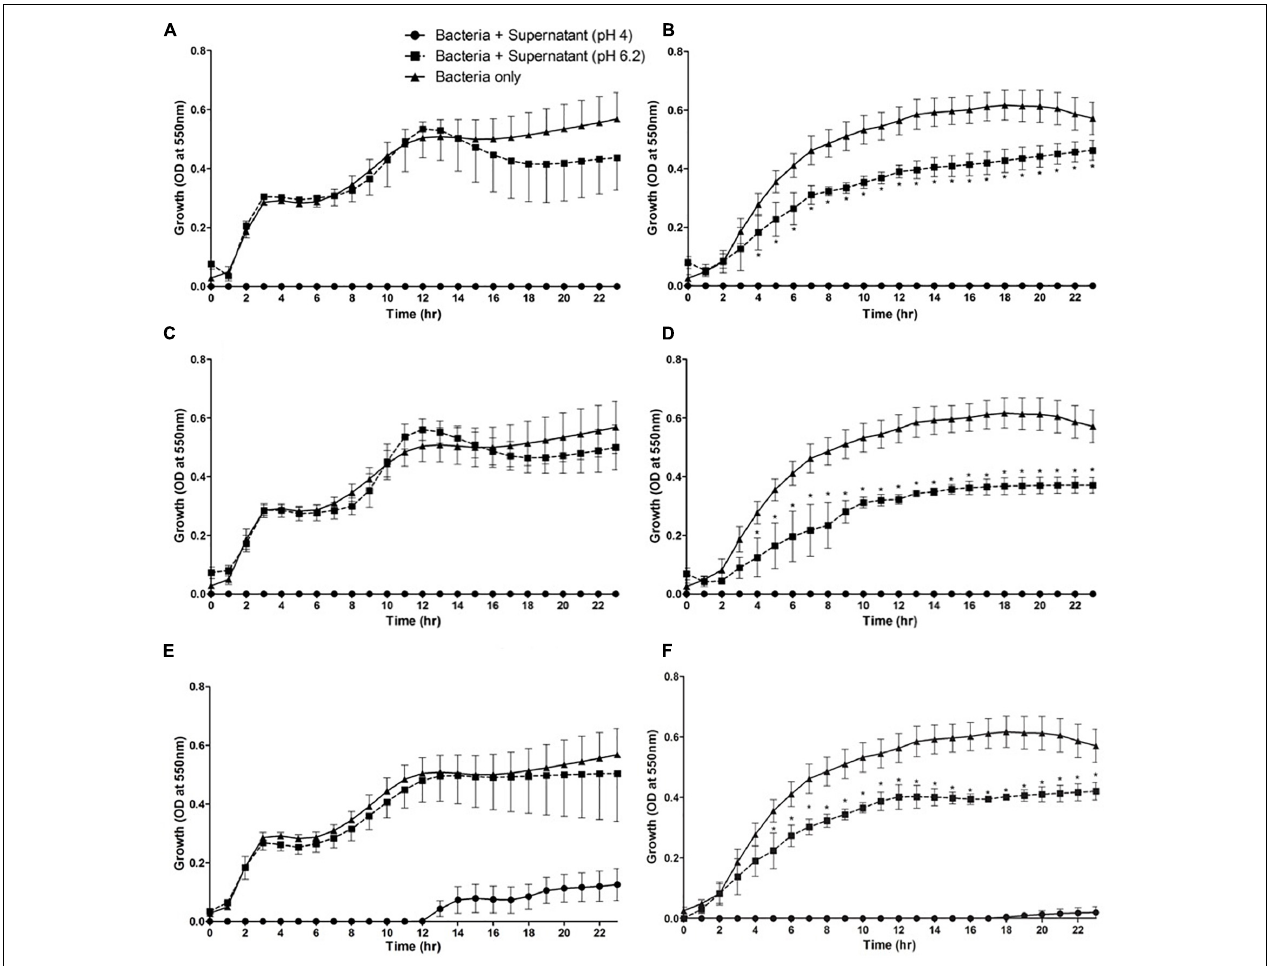
FIGURE 2 | Growth profiles of pathogenic Vibrio species in the presence of culture supernatants from lactic acid bacteria in vitro . Vibrio harveyi (A,C,E) and V. alginolyticus (B,D,F) were incubated in the presence of culture supernatant from Lactobacillus plantarum (A,B) , Pediococcus acidilactici (C,D) , and Carnobacterium maltaromaticum (E,F) . Mean values ± S.E.M, n = 5 (per bacterium, 15 in total), * P < 0.05 compared to bacteria alone control and cell-free supernatant of the respective lactic acid bacterium at pH